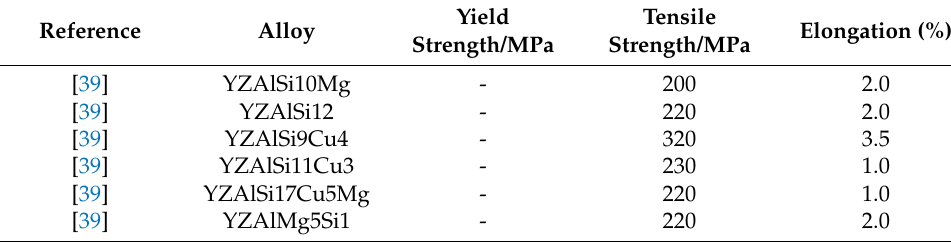
Table 4. Typical mechanical properties of die-cast aluminum alloy test